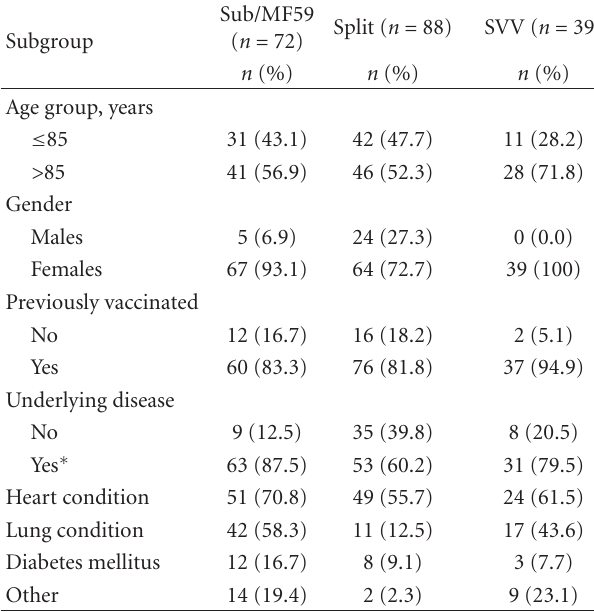
Table 1: Baseline characteristics of the study